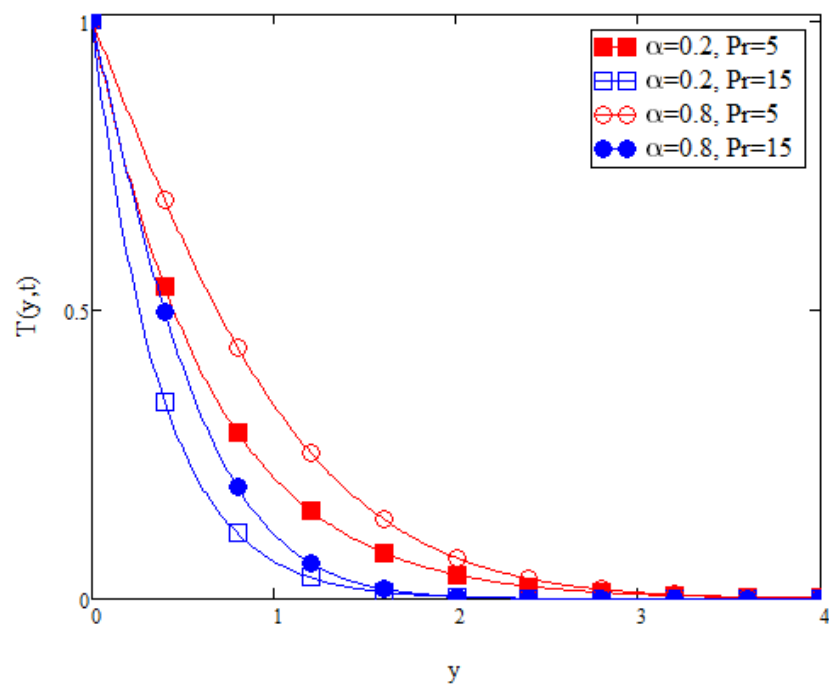
Figure 7. Variation in energy profile due to variations in Pr and α